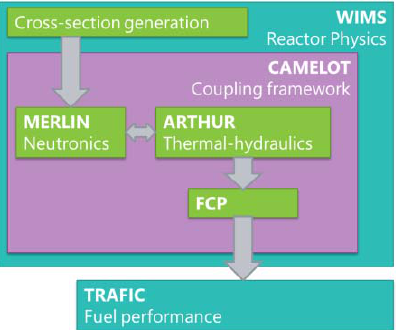
Figure 5. WIMS fast reactor calculation scheme, under